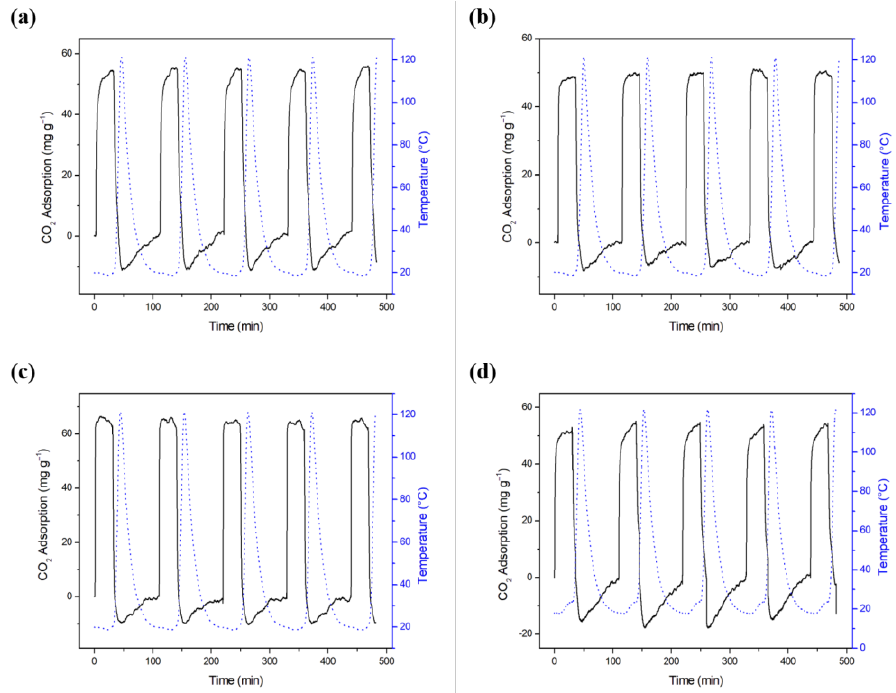
Figure 6. CO 2 adsorption cycles in biochars ( a ) FIB.700, ( b ) ALM.700, ( c ) END.700 and ( d ) DOA.700.